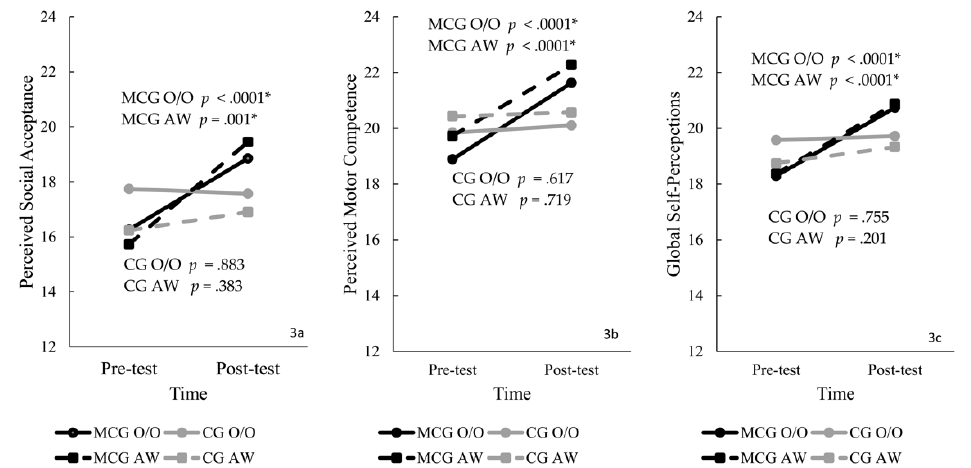
Figure 3. Perceived social acceptance ( 3a ), perceived motor skill competence ( 3b ) and perceived global self-perceptions ( 3c ) by group (* significant results).